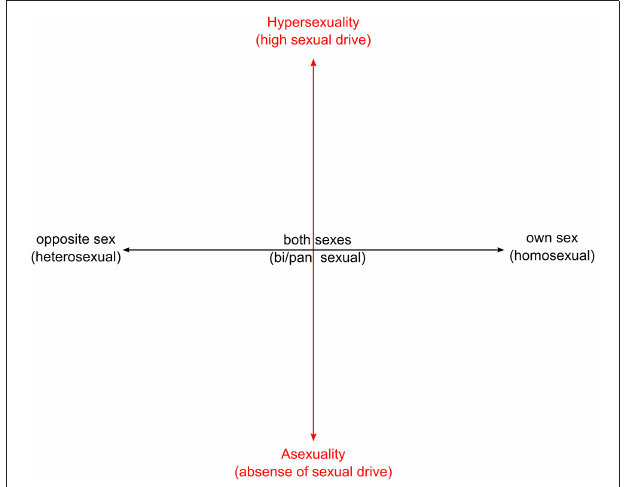
FIGURE 1 | Schematic model of sexual orientation and